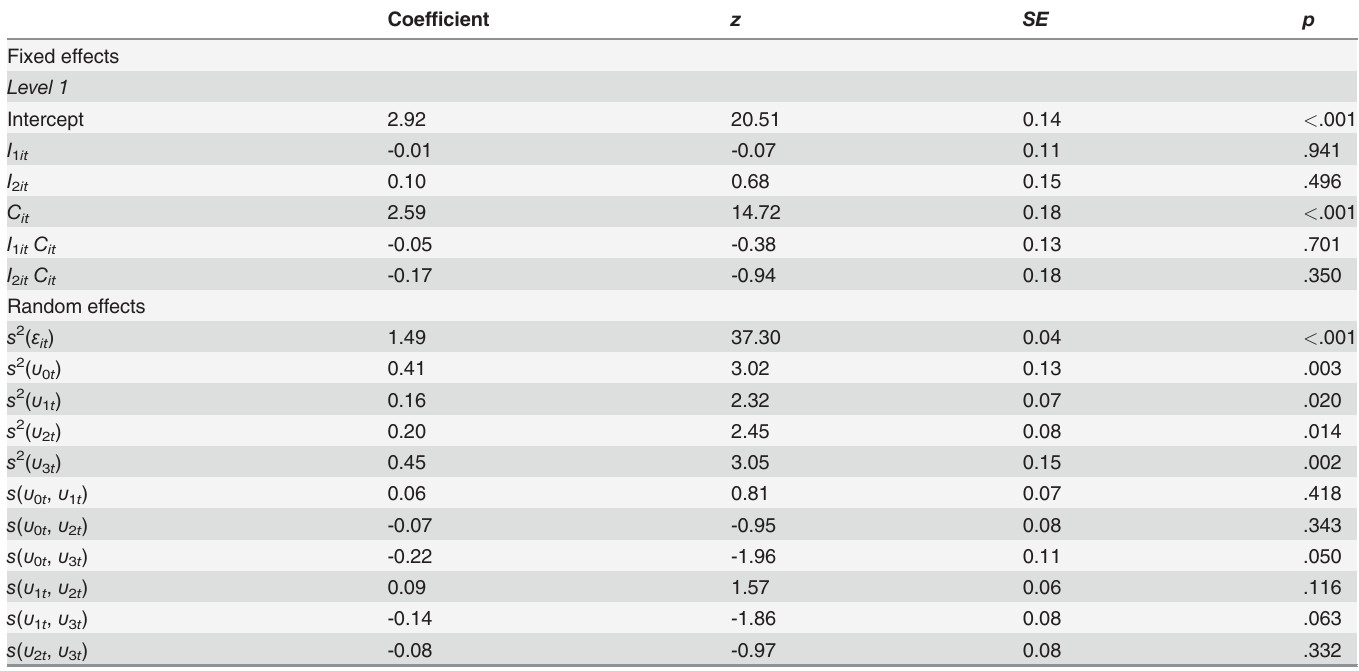
Table 2. Results of the pre-study (Model